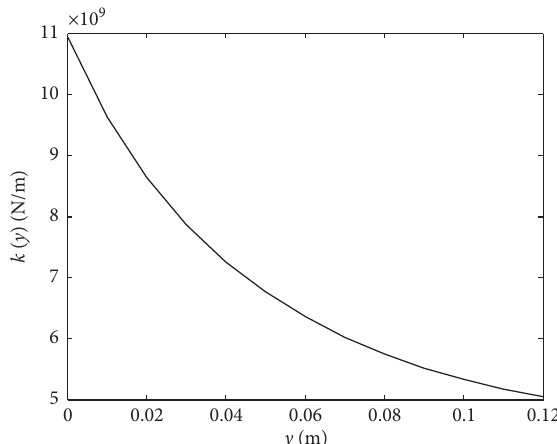
Figure 3: Curve of the spring stiffness with respect to the vibration displacement of the hydraulic cylinder.